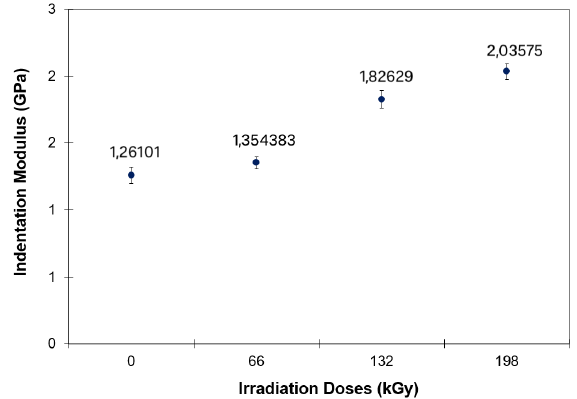
Figure 4. Indentation modulus of tested PBT 35%GF.